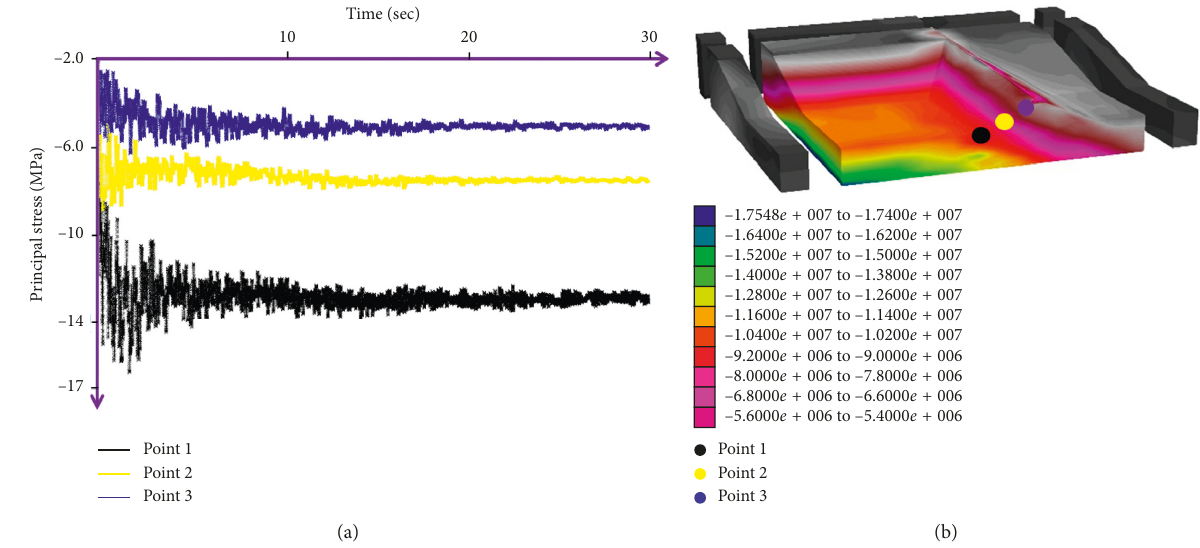
Figure 19: (a) Principal stress-time graphic for the Kobe earthquake. (b) Contour plot diagram for 30 th second of Kobe